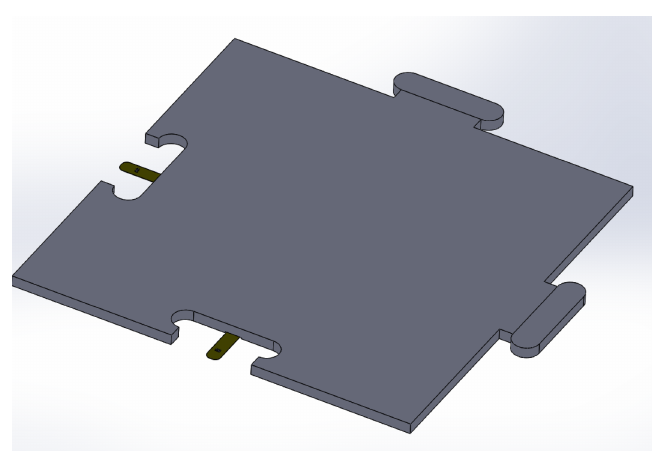
Figure 4. Upper side of the foam tile.